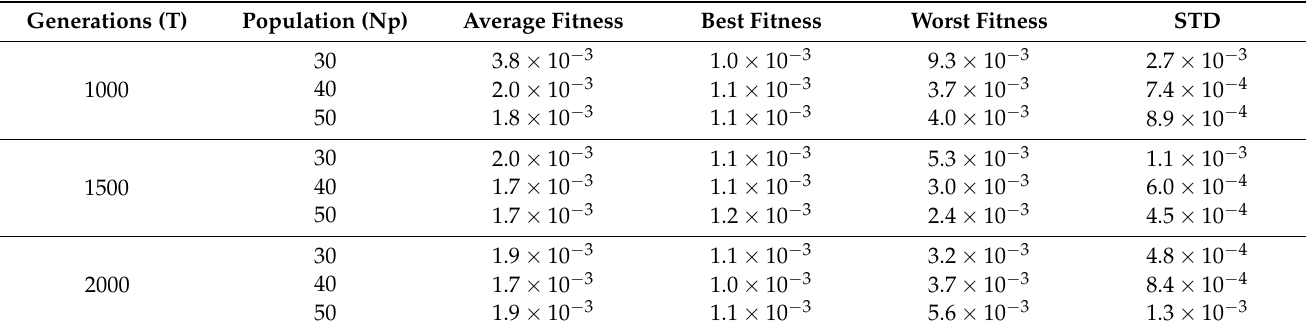
Table 12. AO analysis with respect to generation and population sizes at 0.04 noise variance.